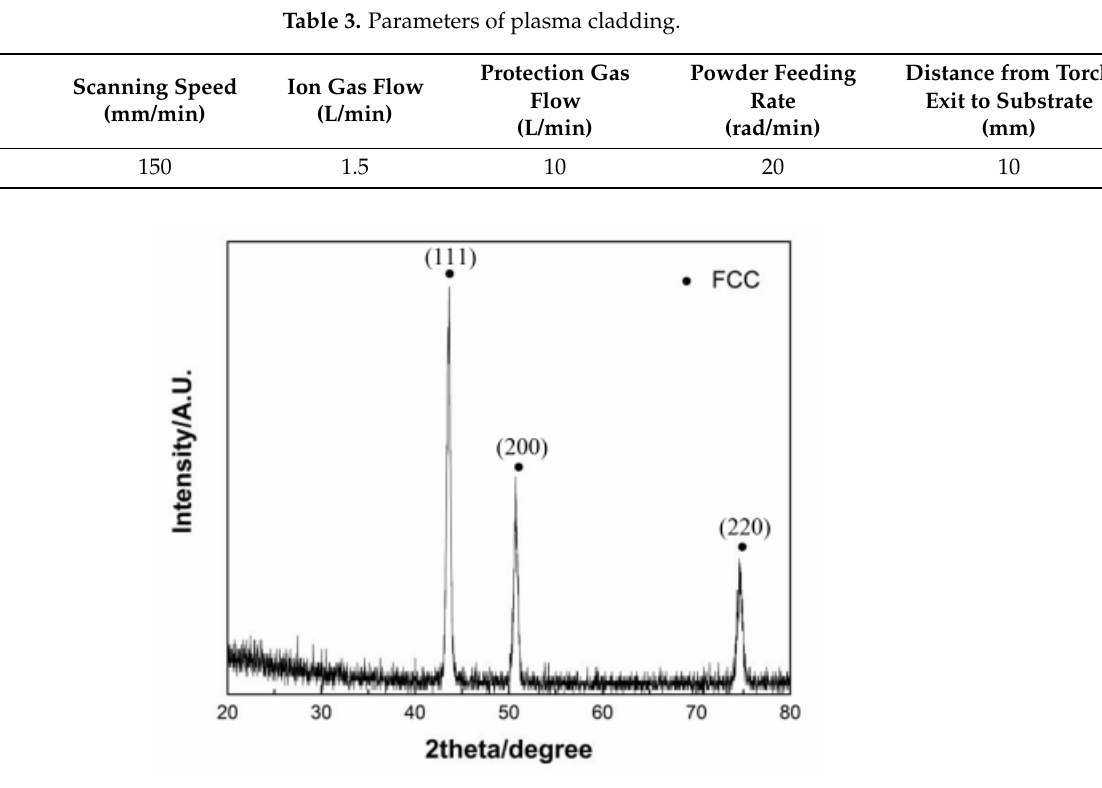
Figure 2. XRD pattern of CoCrFeNiMn powder.